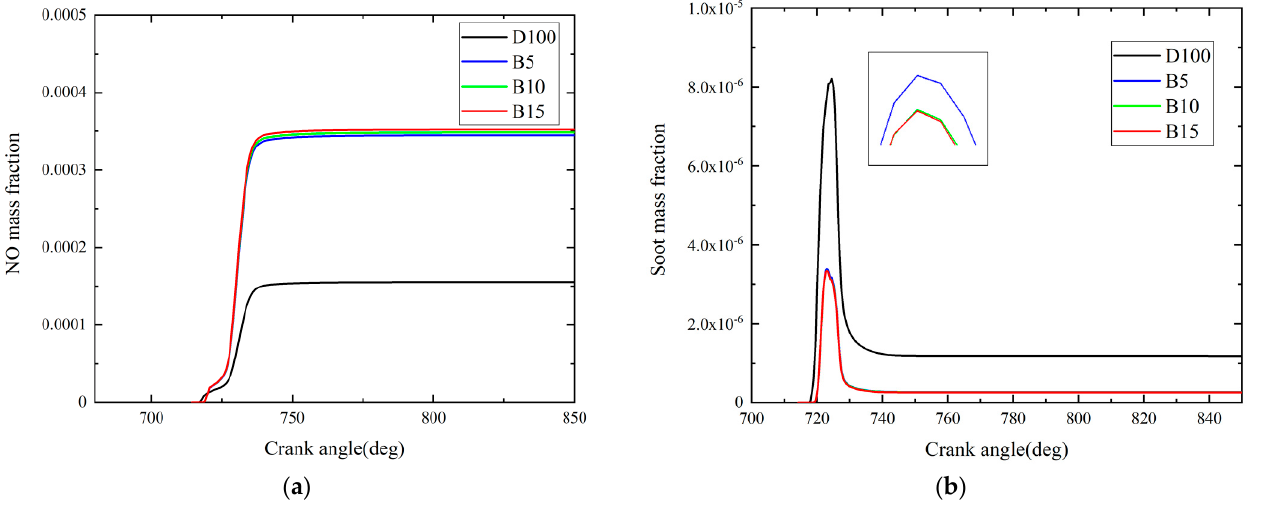
Figure 7. ( a ) NO emission from different ratios of biodiesel; ( b ) Soot emission from different ratios of biodiesel. of